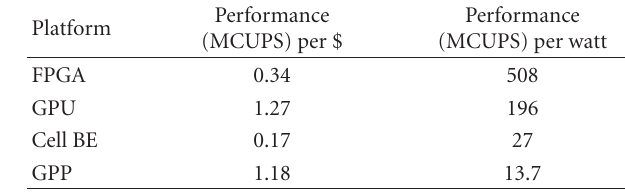
Table 8: Power consumption of the Smith-Waterman algorithm implementation on all four technologies.